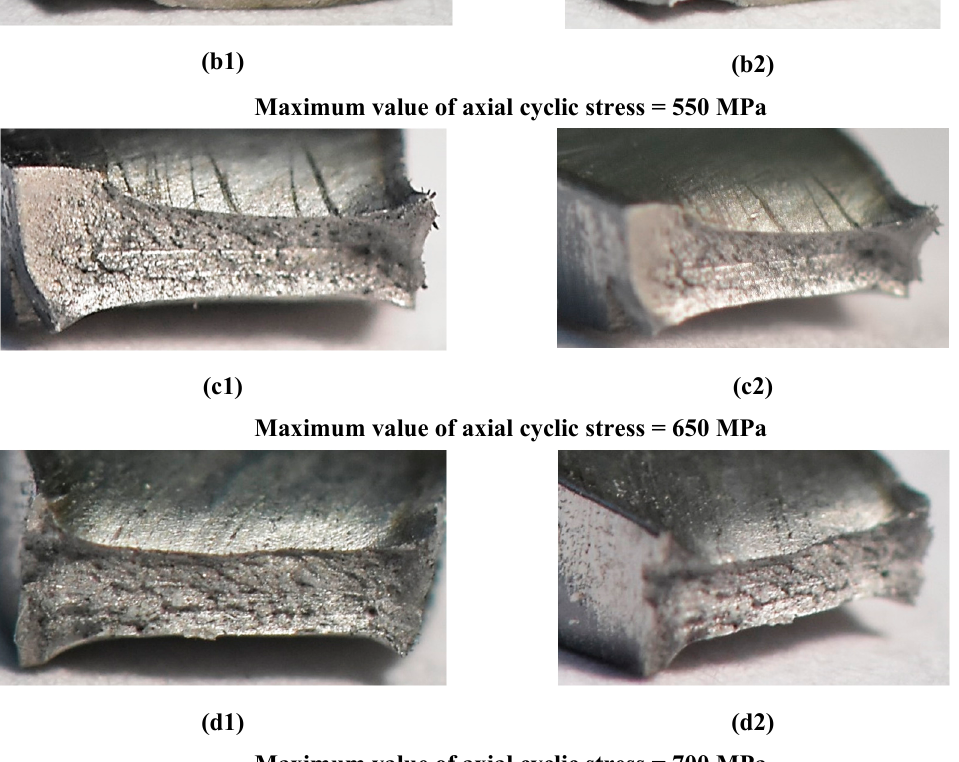
Figure 12. Fracture zones of the Docol 1200 M weld manufactured at the micro-jet cooling technique after fatigue test under the maximum values of stress of 500 MPa to 700 MPa.